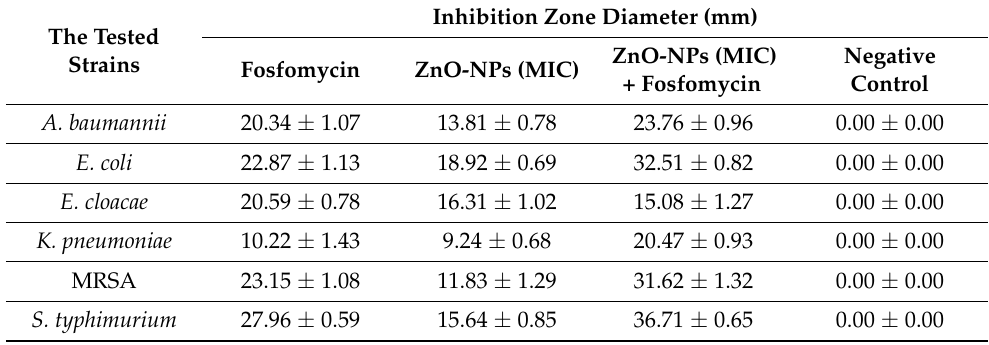
Table 3. Inhibitory zone diameters of ZnO-NPs with fosfomycin against bacterial pathogens. The